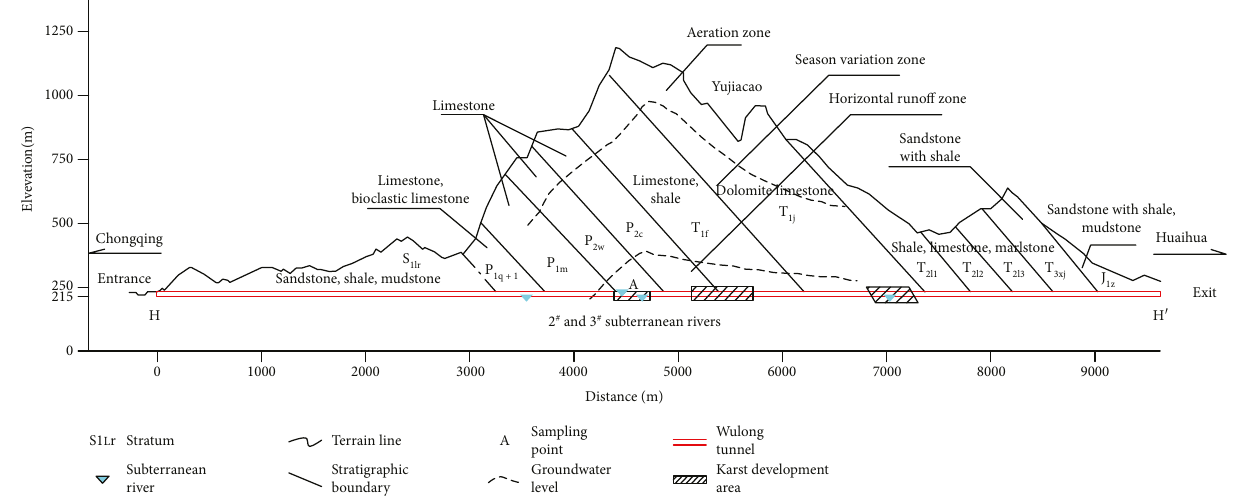
Figure 2: Simpli fi ed hydrogeological cross section of the Wulong tunnel area.